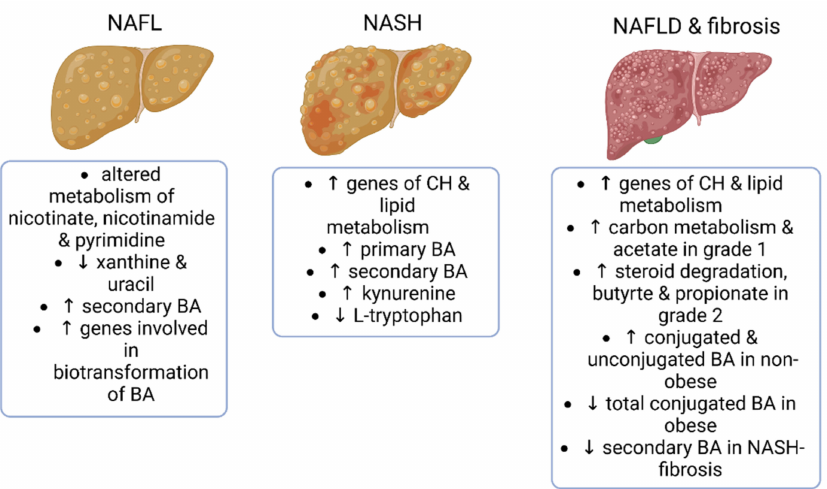
Figure 3. Main findings from studies reporting fecal metagenomics and/or metabolomics in NAFLD and advanced fibrosis. NAFL—non-alcoholic fatty liver; NASH—non-alcoholic steatohepatosis; CH—carbohydrates; BA—bile acids. The figure was created using